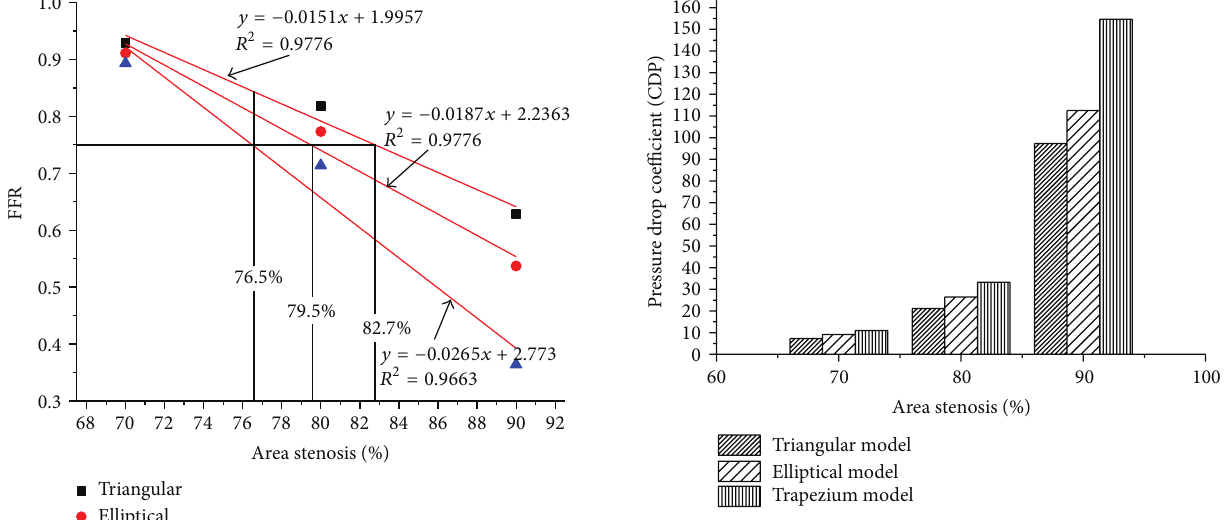
Figure 6: Variation of CDP with % AS in various shapes of models (triangular, elliptical, and trapezium).